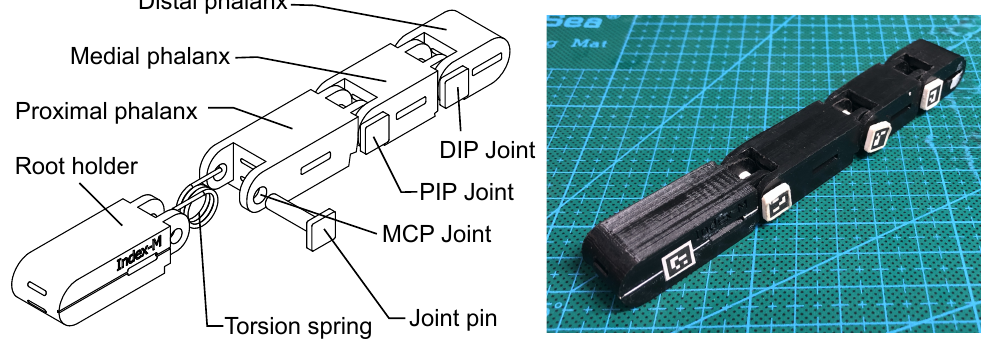
Figure 3. Overview of the dummy finger.